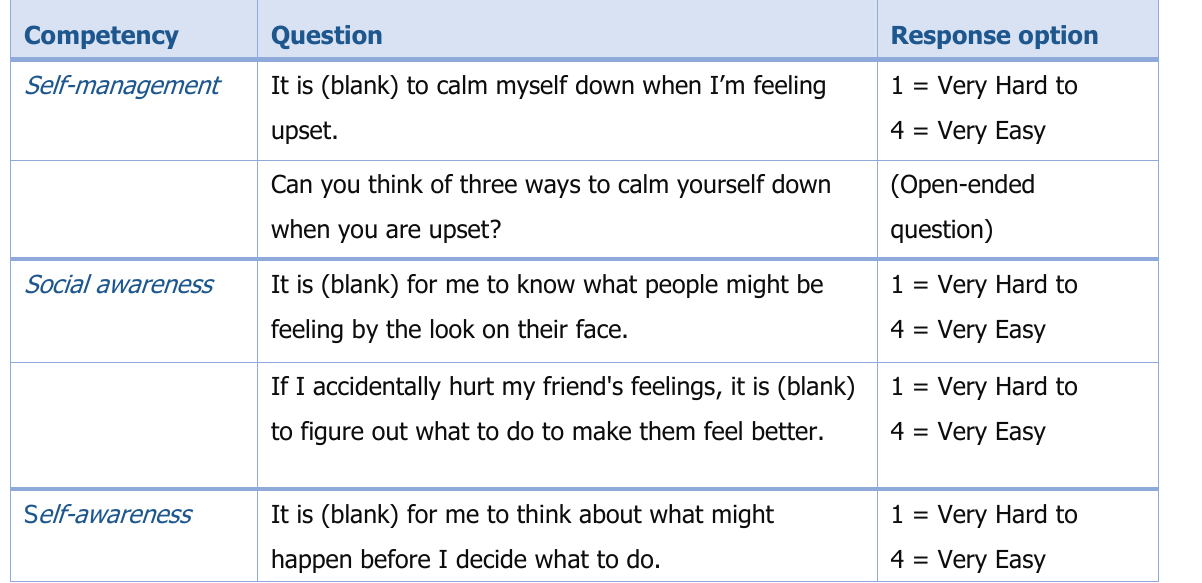
Table 1. Evaluation Questions and Response Choices